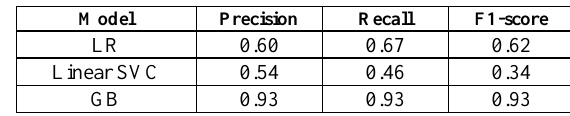
Table 3. Results for each machine learning algorithm